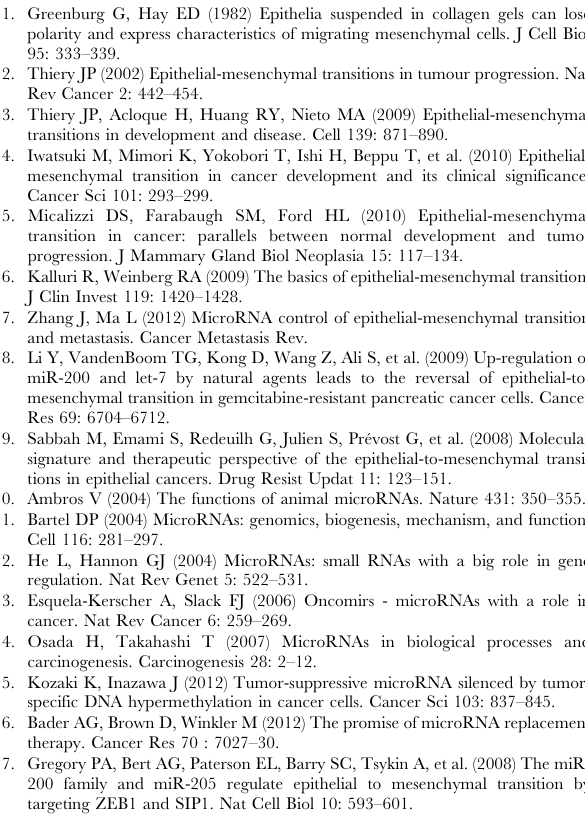
Table S1 Primers used in this study. Table S2 Summary of functional-based screening using 470 dsRNAs mimicking mature miRNAs (Pre-miR TM miRNA Pre- cursor Library - Human V3, Ambion) and a stable Panc1 clone transfected with a reporter construct containing a promoter sequence of CDH1/E-cadherin in the 5 9 upstream region of the ZsGreen1 reporter gene. Table S3 Correlation between clinicopathological characteris- tics and status of miR-655 expression in primary ESCC